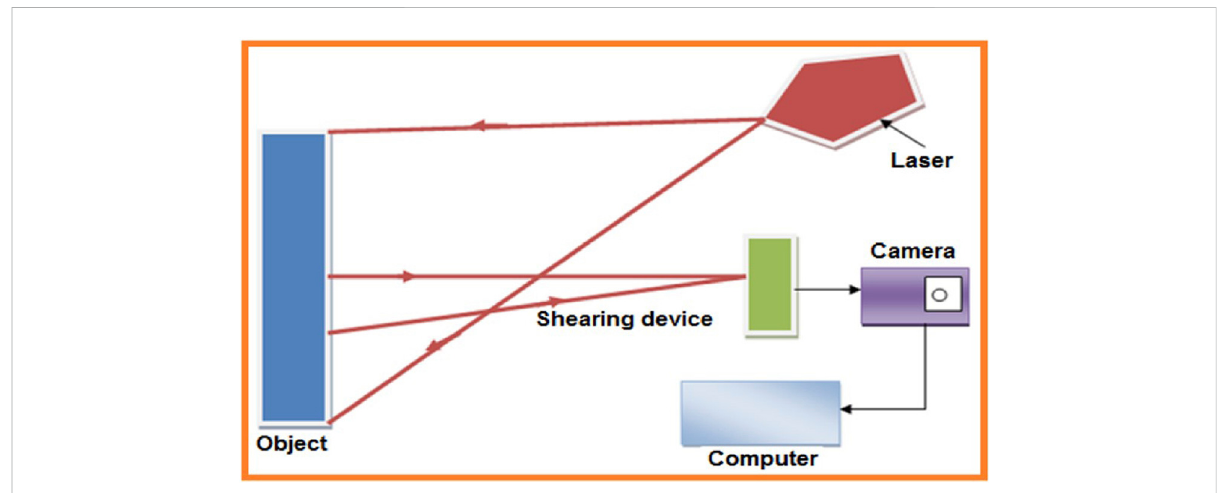
FIGURE 5 The working principle of digital shearography technique (Kumpati et al., 2021).